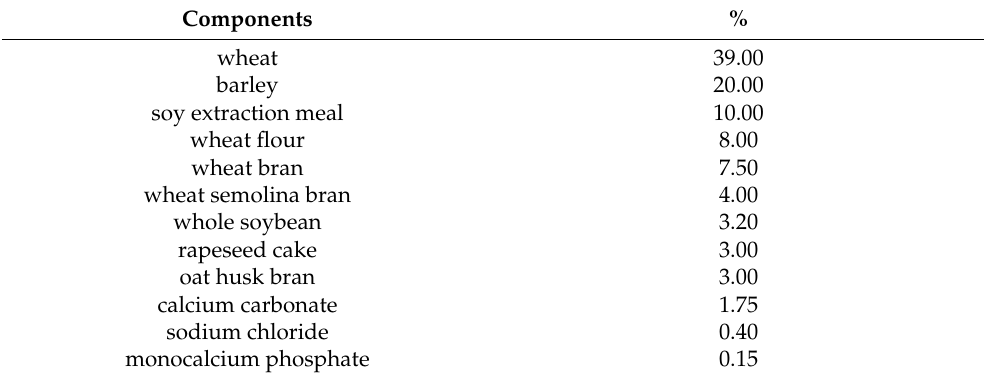
Table 1. Composition of the commercial lactation diet according to the declaration.